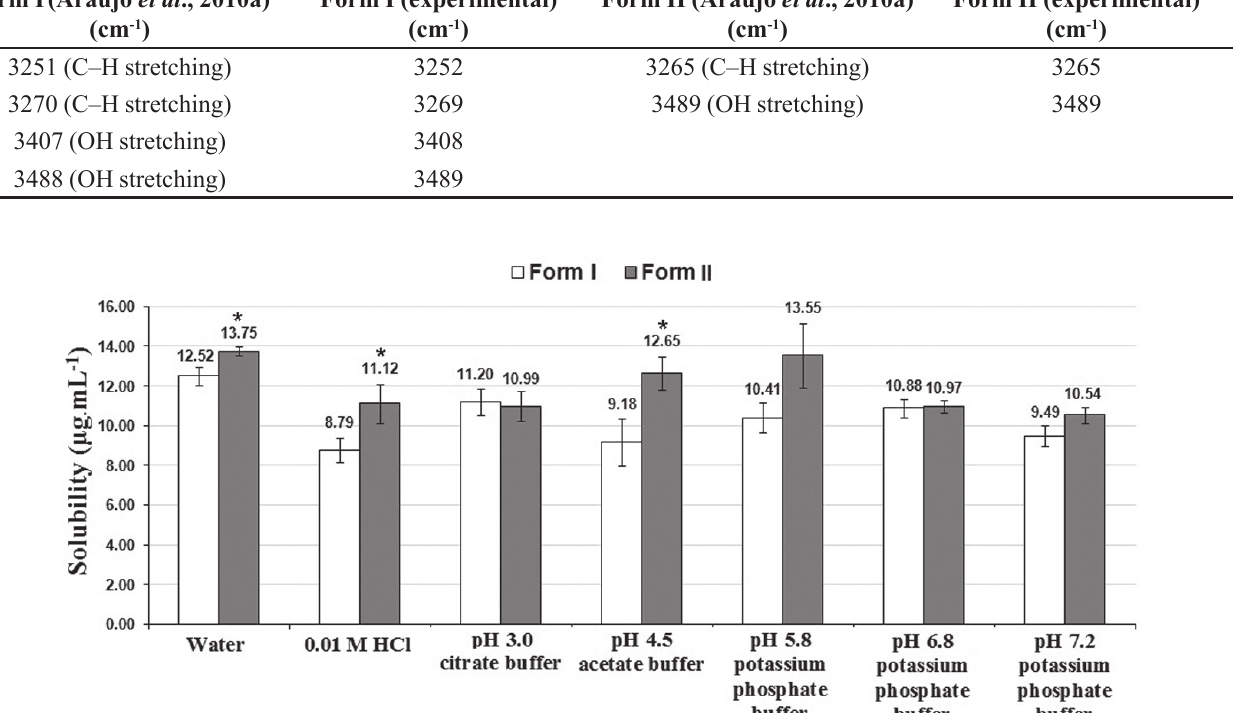
FIGURE 4 - Solubility values of tibolone forms I and II at 25 °C. Values of form II marked with asterisks differ statistically from solubility values of form I at a significance level of